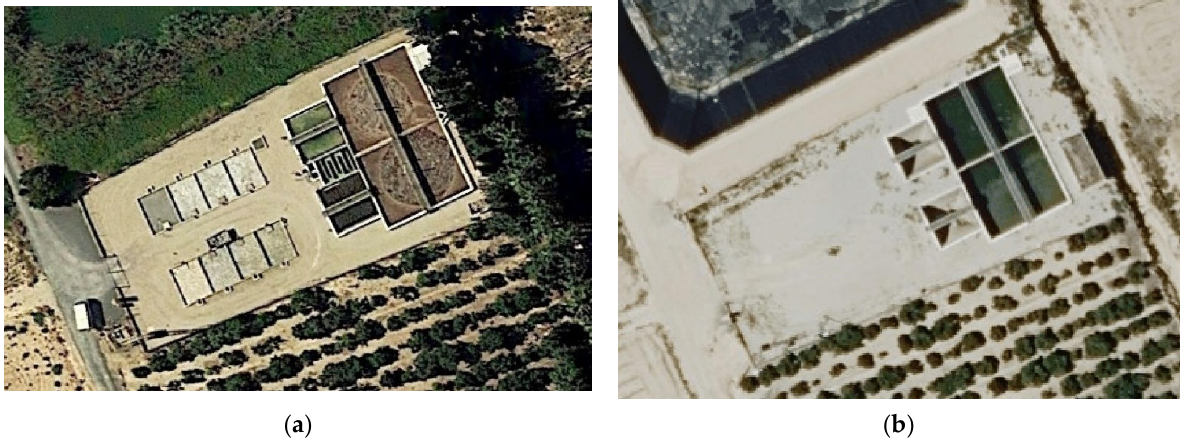
Figure 4. ( a ) Doña Pepa WWTP before its transformation; ( b ) Doña Pepa WWTP after transformation into a combined sewer system storm overflow tank. Source: ( a ) Google Earth (7 June 2018); ( b ) ICV (2021) (21 June 2021). Own elaboration.